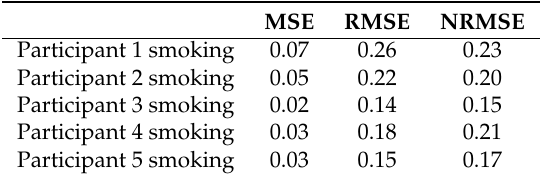
Table 5. The overall error rate of the proposed model during week days days.